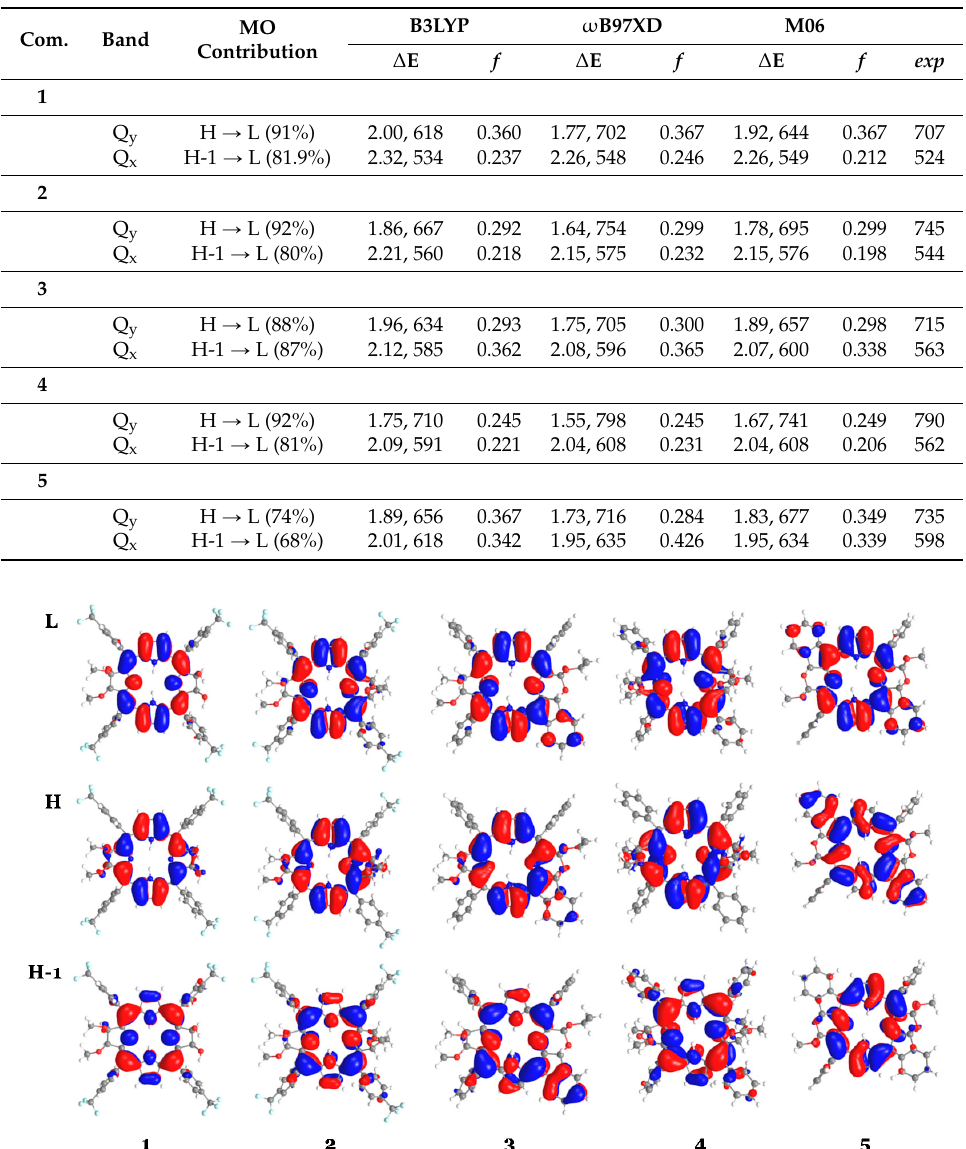
Table 1. Main vertical singlet electronic energies ∆ E (eV, nm), oscillator strengths, f , and main configuration for 1 – 5 compounds in dichloromethane solvent computed by employing the 6-31+G* basis set at ω B97XD, M06 and B3LYP level of theory on the B3LYP/6-31G* optimized geometries. Experimental values in nm are taken from reference [36].